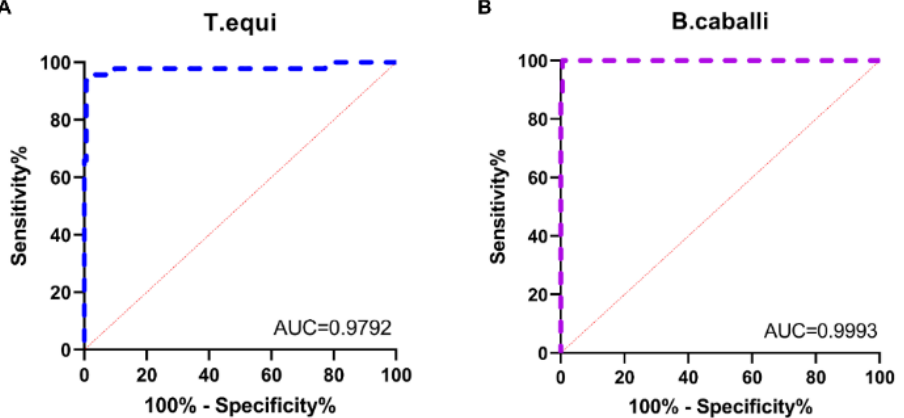
Figure 5. ROC curve analysis of the novel cELISA assay for clinical sample testing. The ROC curve was plotted by calculating the diagnostic sensitivity and specificity of the novel cELISA PI values relative to the results of the commercial cELISA assay ( A , B ).